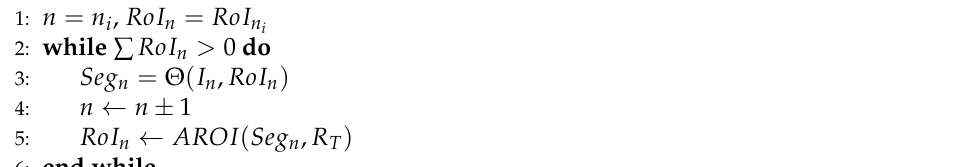
Algorithm 1 : The algorithmic steps followed in the proposed framework for nodule investigation along the axial view.